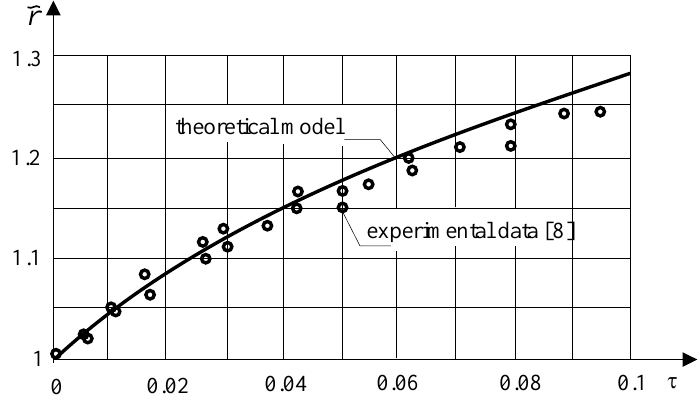
Figure 7. Comparison of the theoretical model with the data from the experiment.